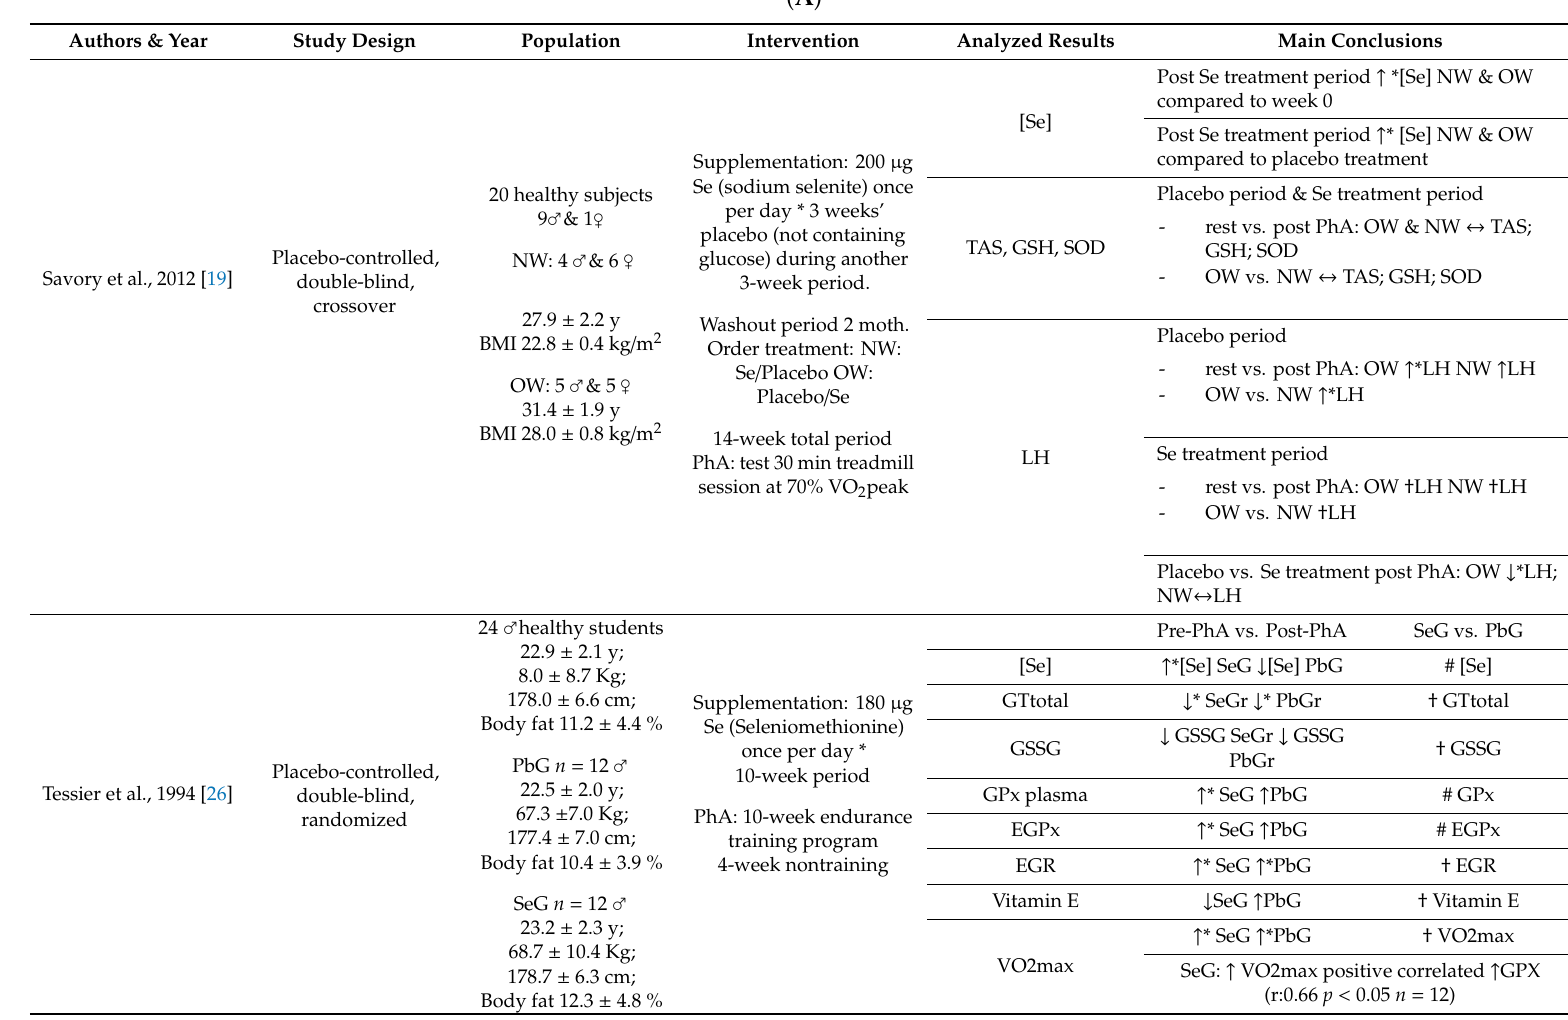
Table 3. Characteistics of the studies included in the systematic